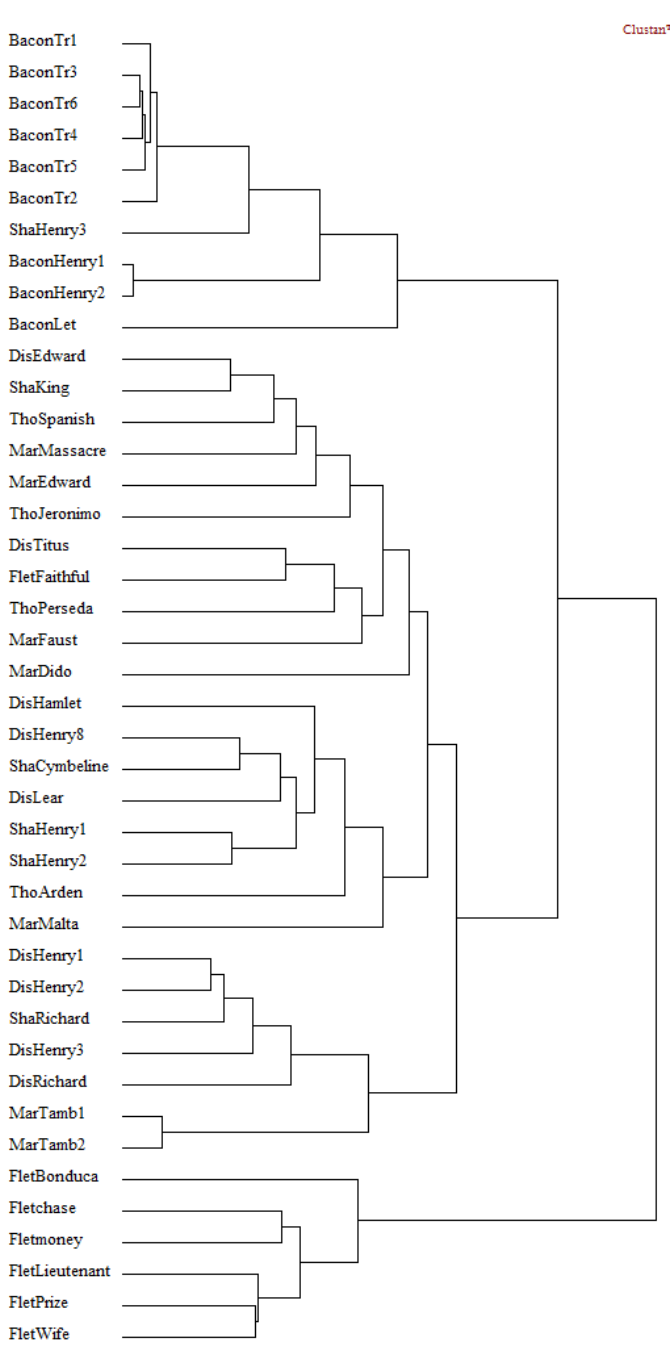
Figure 11. The hierarchical cluster analysis of D FW using Product-Moment correlation and Mean